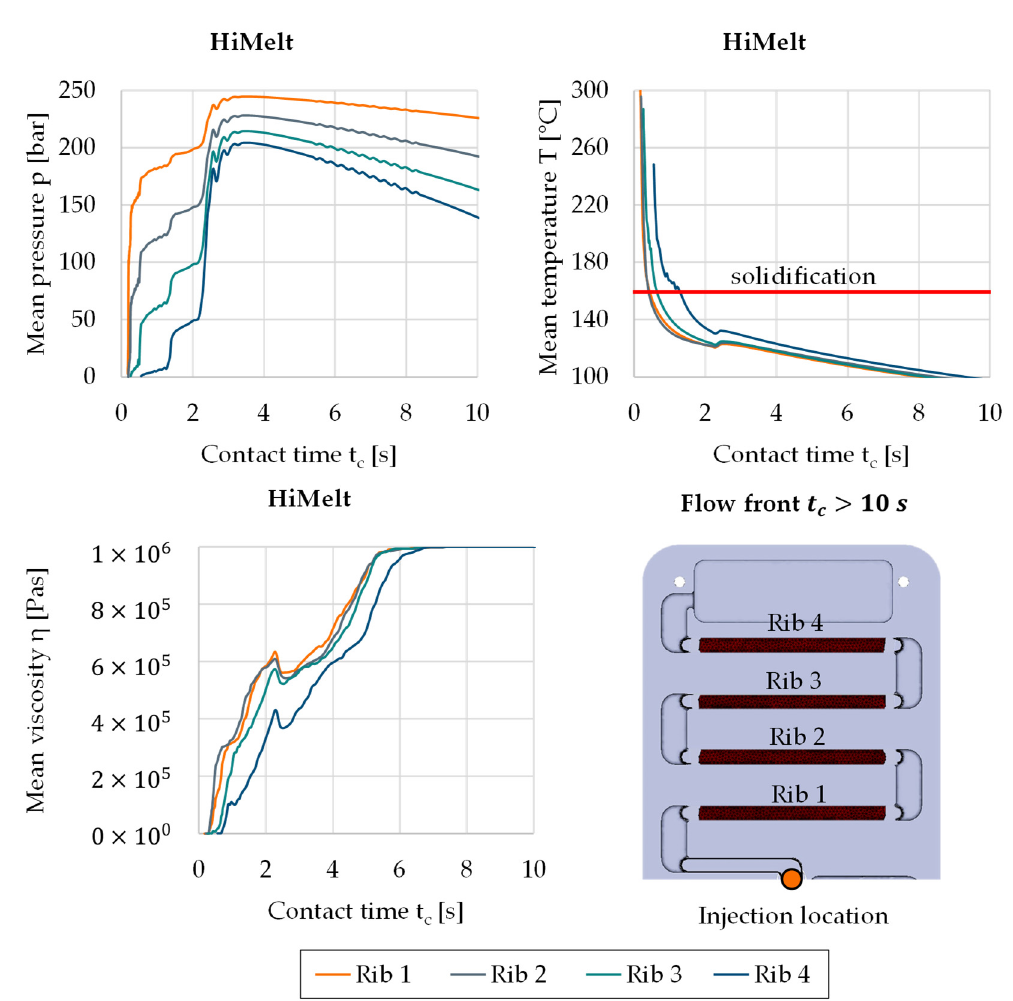
Figure A1. Results of the injection moulding simulation by means of process parameter set “HiMelt” for individual ribs of the cross-tension test specimen and final flow front after the overmoulding process.